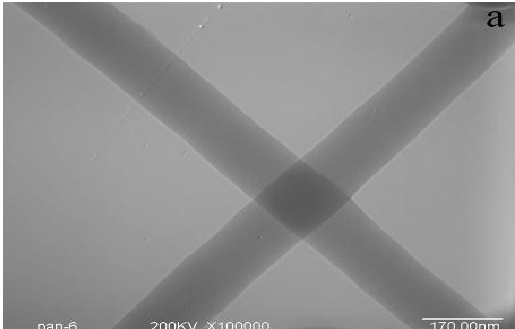
Figure 2. TEM images: ( a ) PAN nanofibers; ( b–d ) PAN/SWNTs nanofibers with SWNTs concentration 1